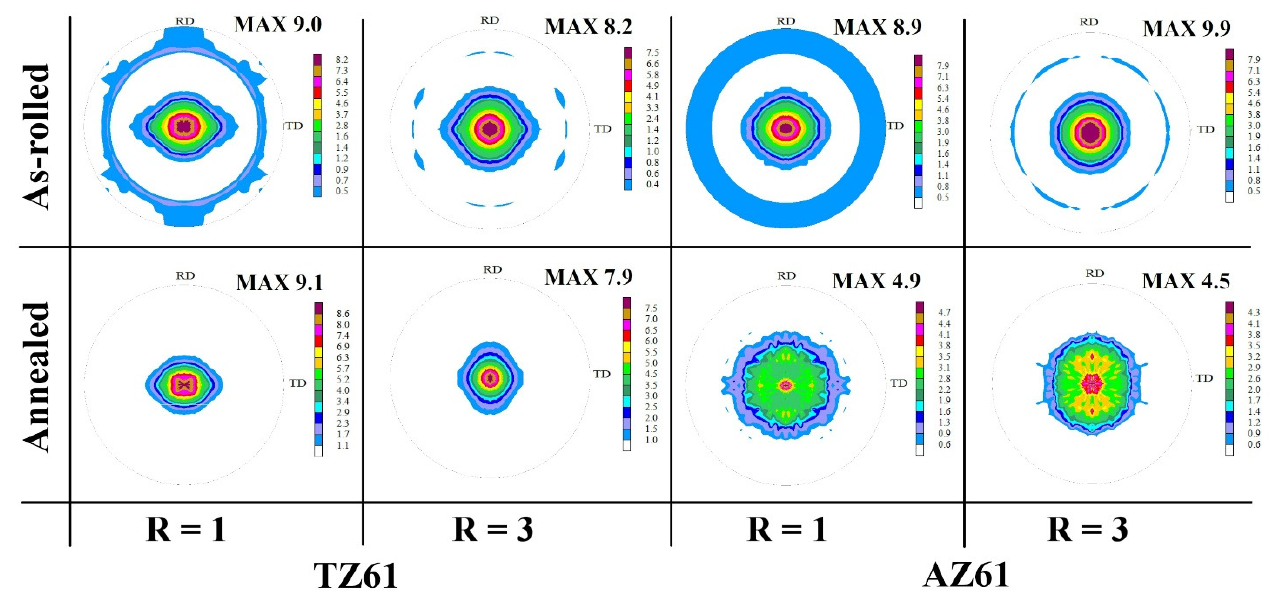
Figure 5. The (0002) pole figures of the as-rolled and annealed TZ61 and AZ61 sheets processed at R = 1 and 3.